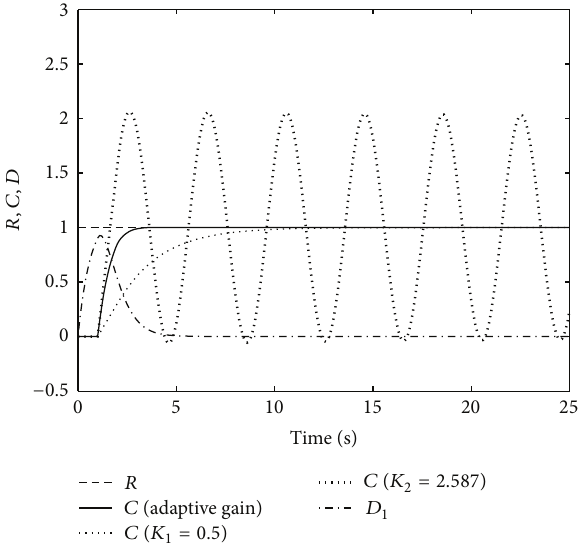
Figure 9: Step responses of Example 1 for constant gains ( 𝐾 = 0.5 and 2.587) and adaptive gain with 𝐷 1